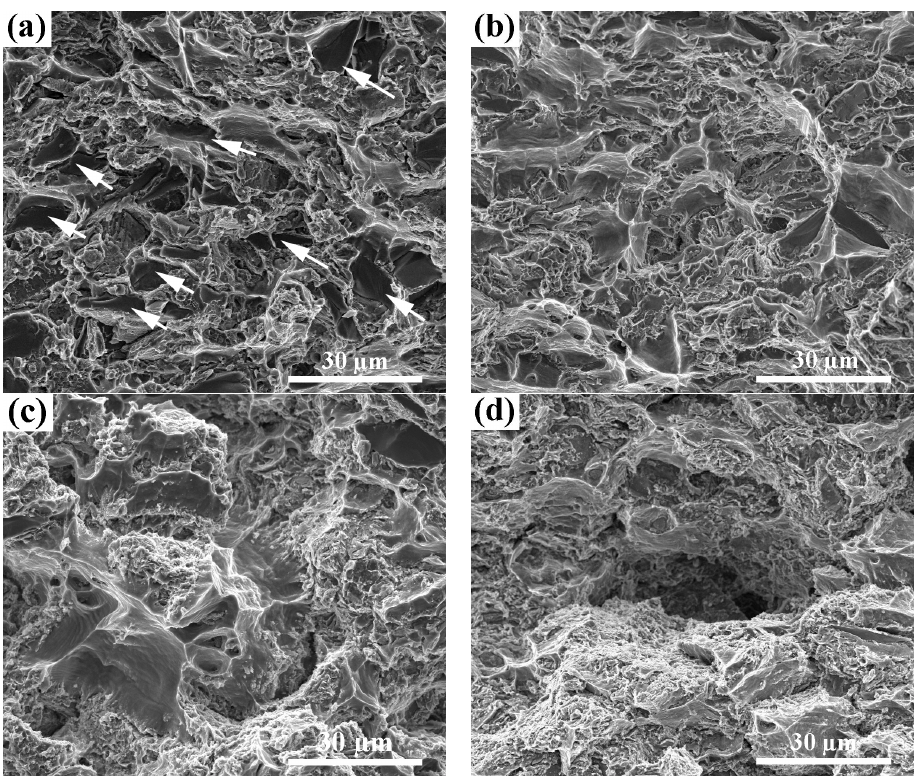
Figure 8. Fractographsof the composite tested at temperatures of ( a ) 25 °C; ( b ) 200 °C; ( c ) 250 °C; and ( d ) 300 °C.